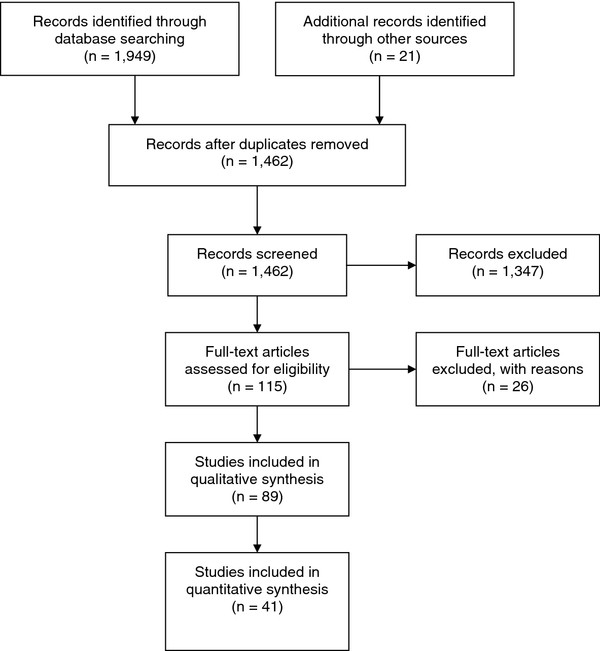
Flow diagram for study selection.